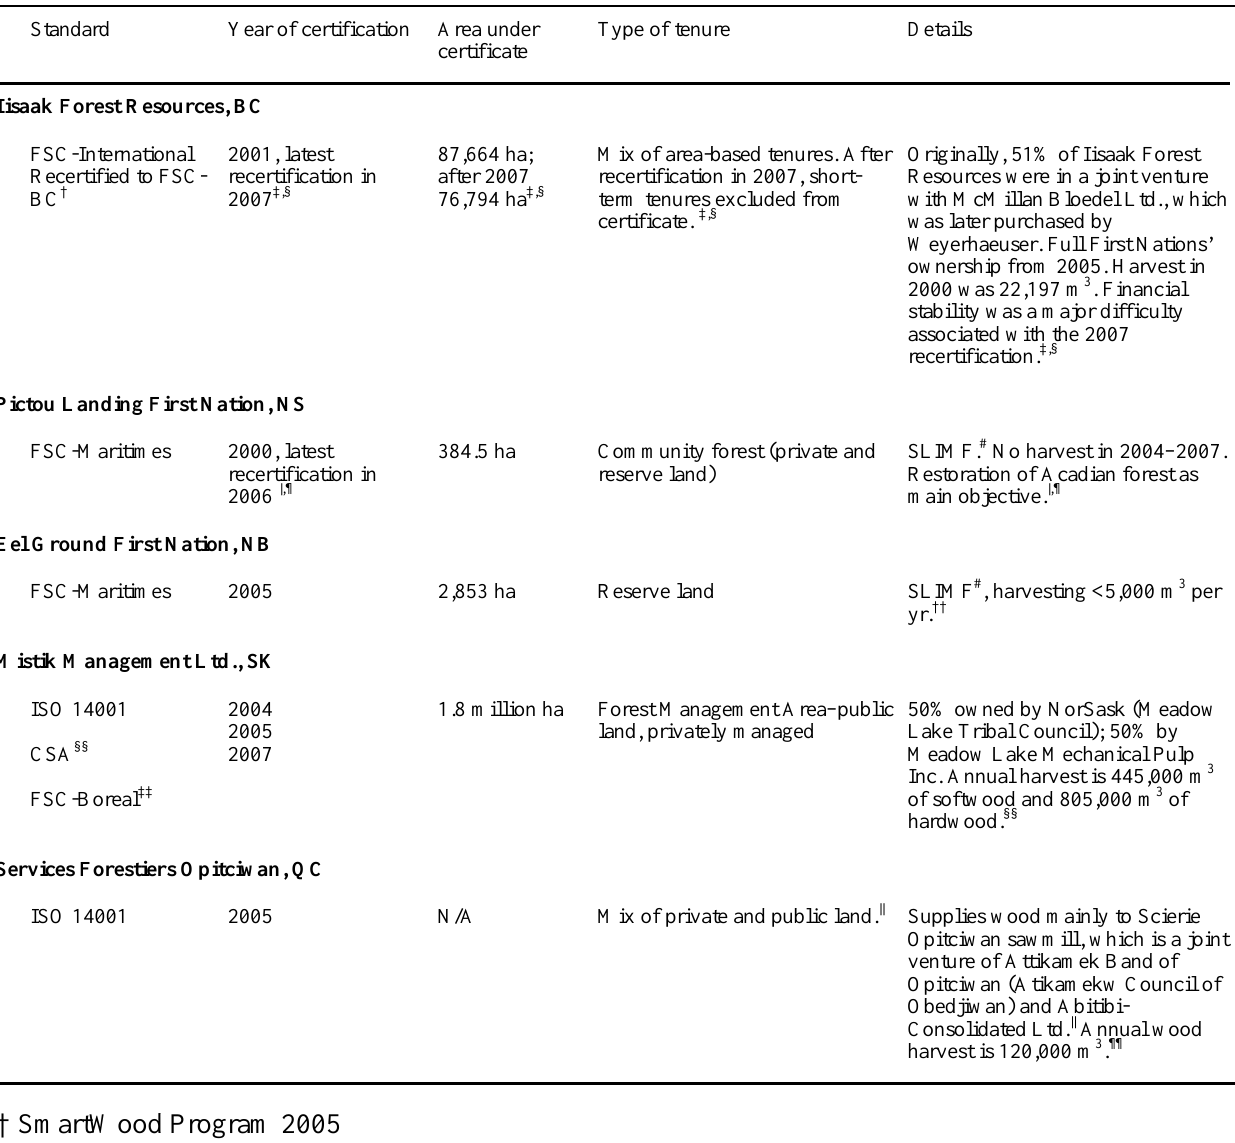
Table 3. Currently certified Aboriginal forest